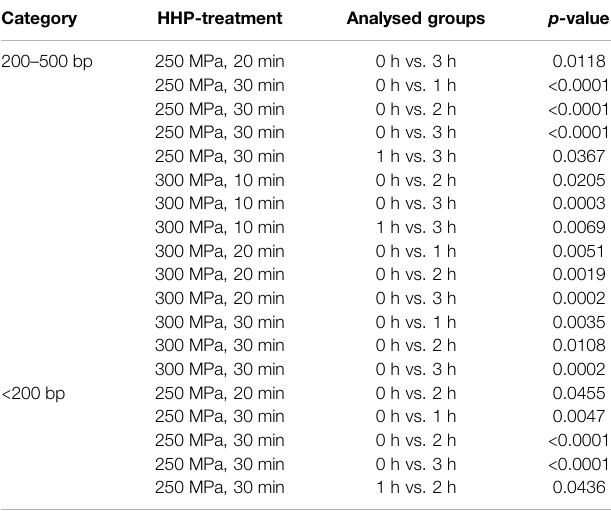
TABLE 2 | Overview of the statistically signi fi cant results of the DNA-fragment analysis over time. Category